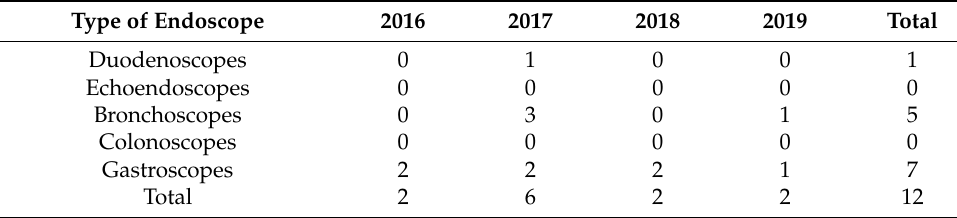
Table 3. Number of positive endoscopes between January 2016 and December